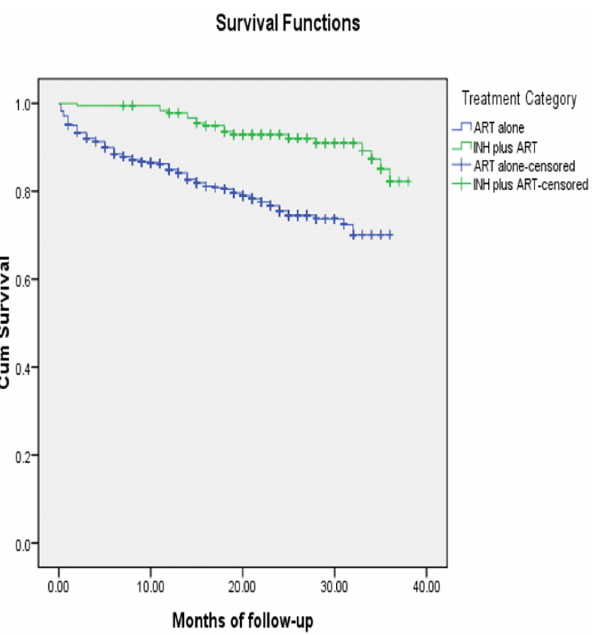
Fig 2. Kaplan Meier survival curve among HIV patients treated by ART alone versus INH plus ART.